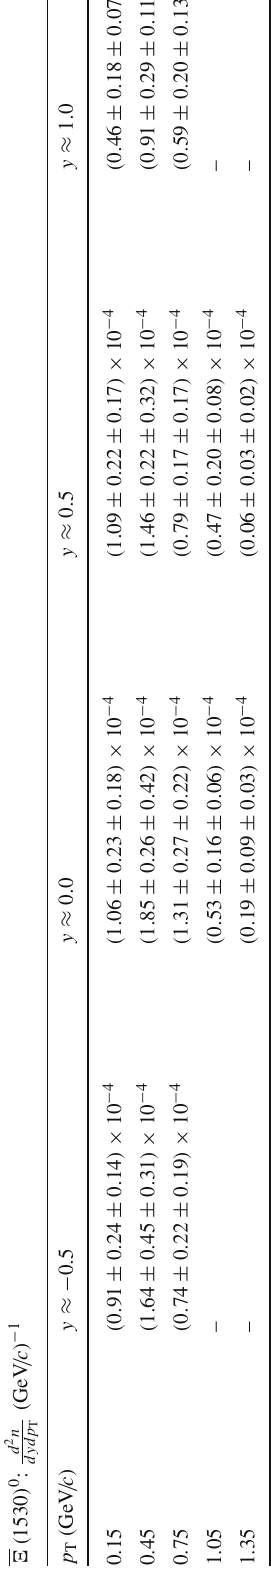
transverse momentum are listed in Table 5. The ratio of the rapidity spectra are listed in Table 6 and drawn in Fig. 10c. The small value of the ratio of mean multiplicities (cid:5) (cid:6) (cid:5) (cid:6) / (cid:2) ( 1530 ) 0 = 0 . 40 ± 0 . 03 ± 0.05 (cid:2) ( 1530 ) 0